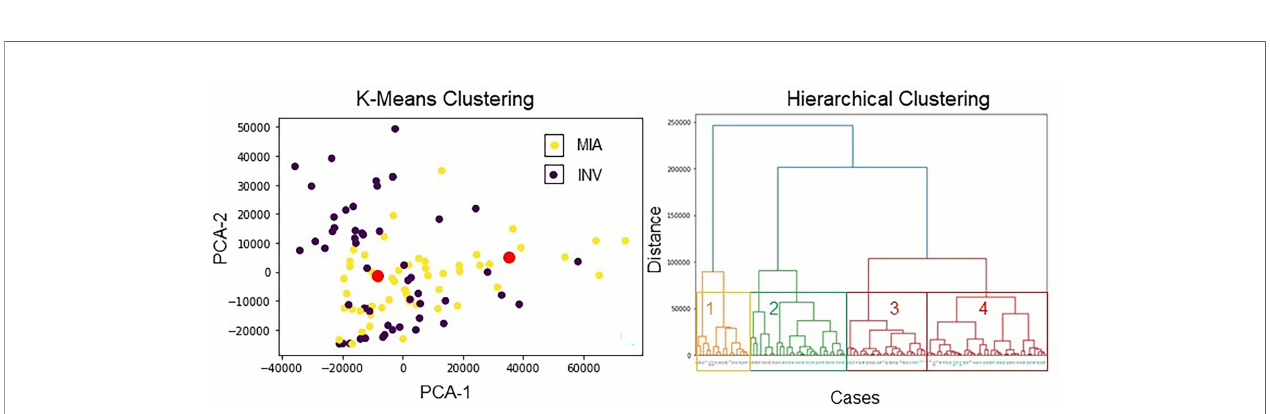
FIGURE 3 | Pathologically proven INV (left image) and MIA (right image) cases presenting as predominantly ground-glass nodular densities which are indistinguishable on CT imaging.